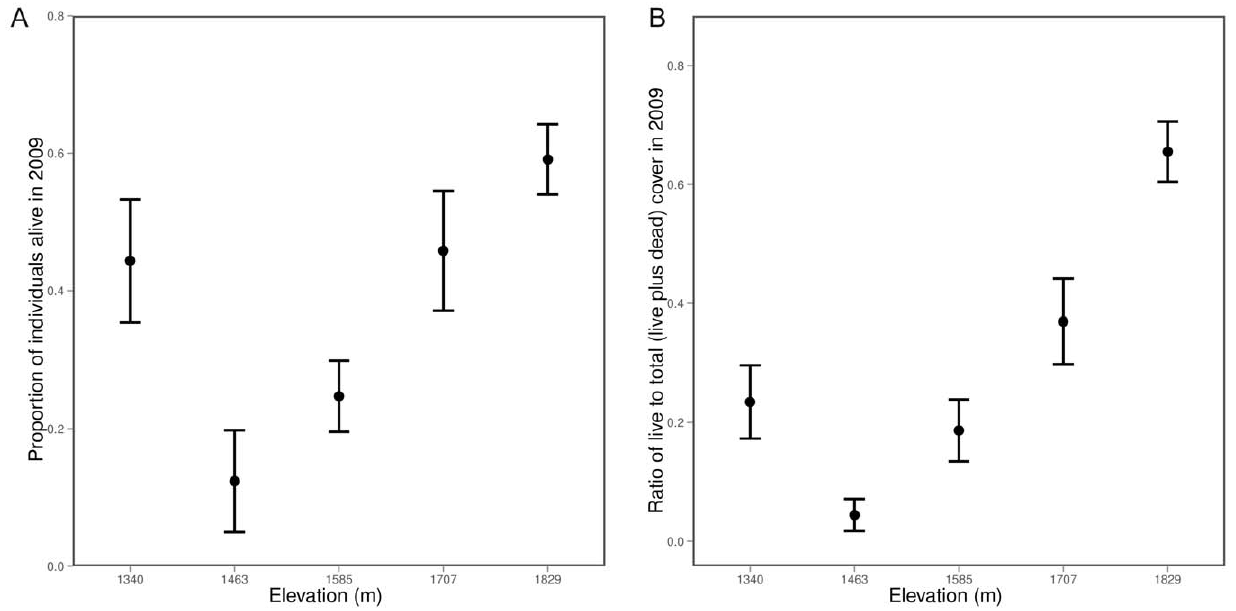
Figure 2. Live C.greggii cover and density relative to live and dead totals. Panel A shows the proportion of living stems to total number of stems (mean + se). Panel B shows proportional contribution of live cover to total cover (mean +